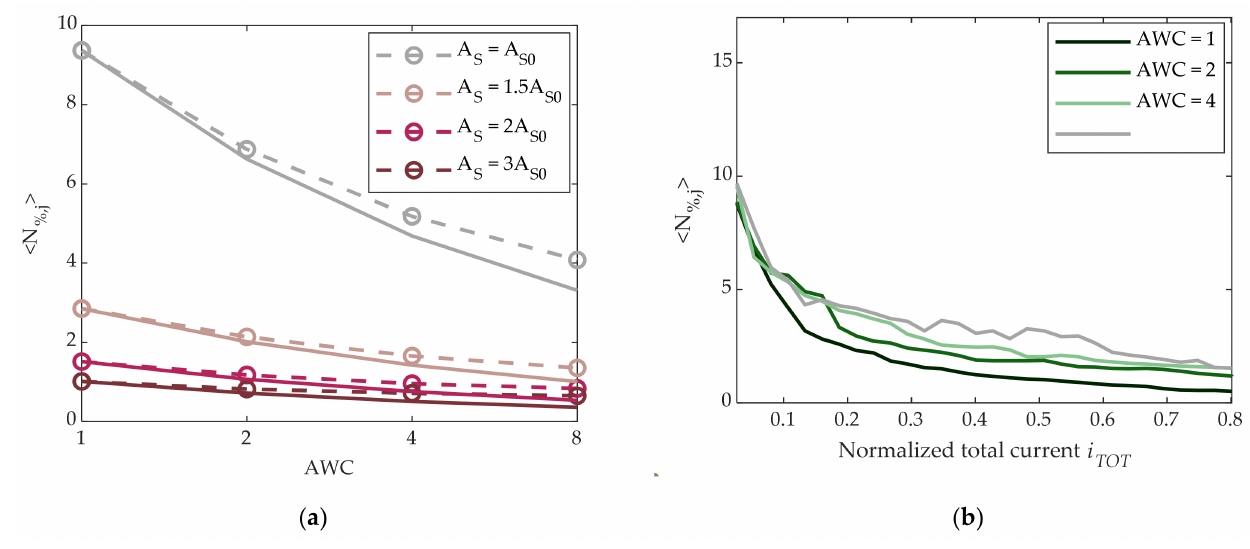
(cid:68) (cid:69) N %, j of N %,j defined in (3) vs. adjacent working cells (AWC) for √ AWC noise behavior. ( b )